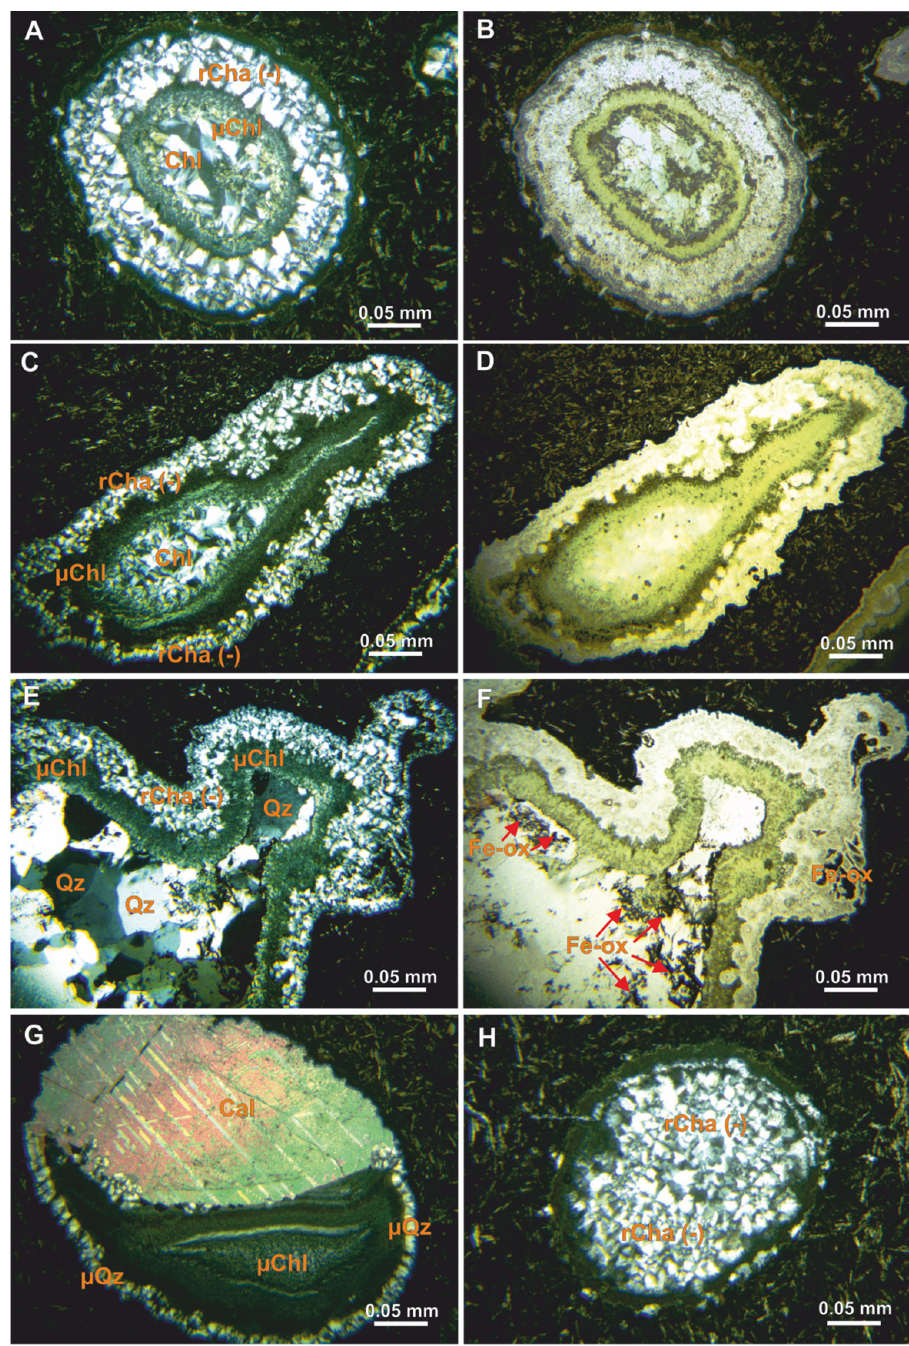
Figure 7. Microphotographs of amygdales in vesicular basalts (mandelstones) from the Priozersk Formation within the Pasha–Ladoga Basin: concentrically zoning rounded ( A , B ) and elongated ( C , D ) amygdales composed of spherulites of radial fibrous chalcedony, fine-grained and plate-like chlorite; ( E , F ) irregularly shaped amygdale consisting of radial fibrous chalcedony, fine-grained chlorite, and macrocristalline quartz core with Fe-oxides in silica matrix; ( G ) bizoning amygdale composed of calcite and concentrically zoning chlorite aggregation; ( H ) Amygdale uniformly filled with radial fibrous chalcedony. ( A , C , E , G , H )—polarized light, crossed nicols; ( B , D , F )—plane polarized light. Abbreviations: Cha (-), length-fast chalcedony; rCha (-), radial fibrous chalcedony; Qz, macrocrystalline quartz; µQz, microcrystalline quartz; Chl, plate-like chlorite; µCha, fine-grained chlorite.